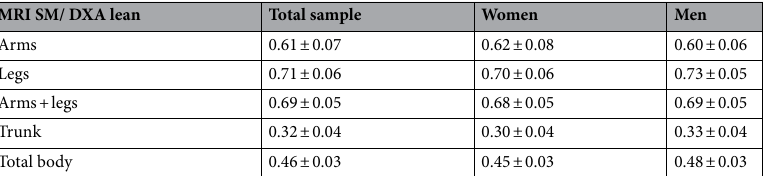
Table 2. Proportions of DXA-measured lean mass as MRI-measured SM (kg/kg; X ± SD). None of the mean differences between women and men were statistically significant. DXA dual-energy X-ray absorptiometry, MRI magnetic resonance imaging, SM skeletal muscle.